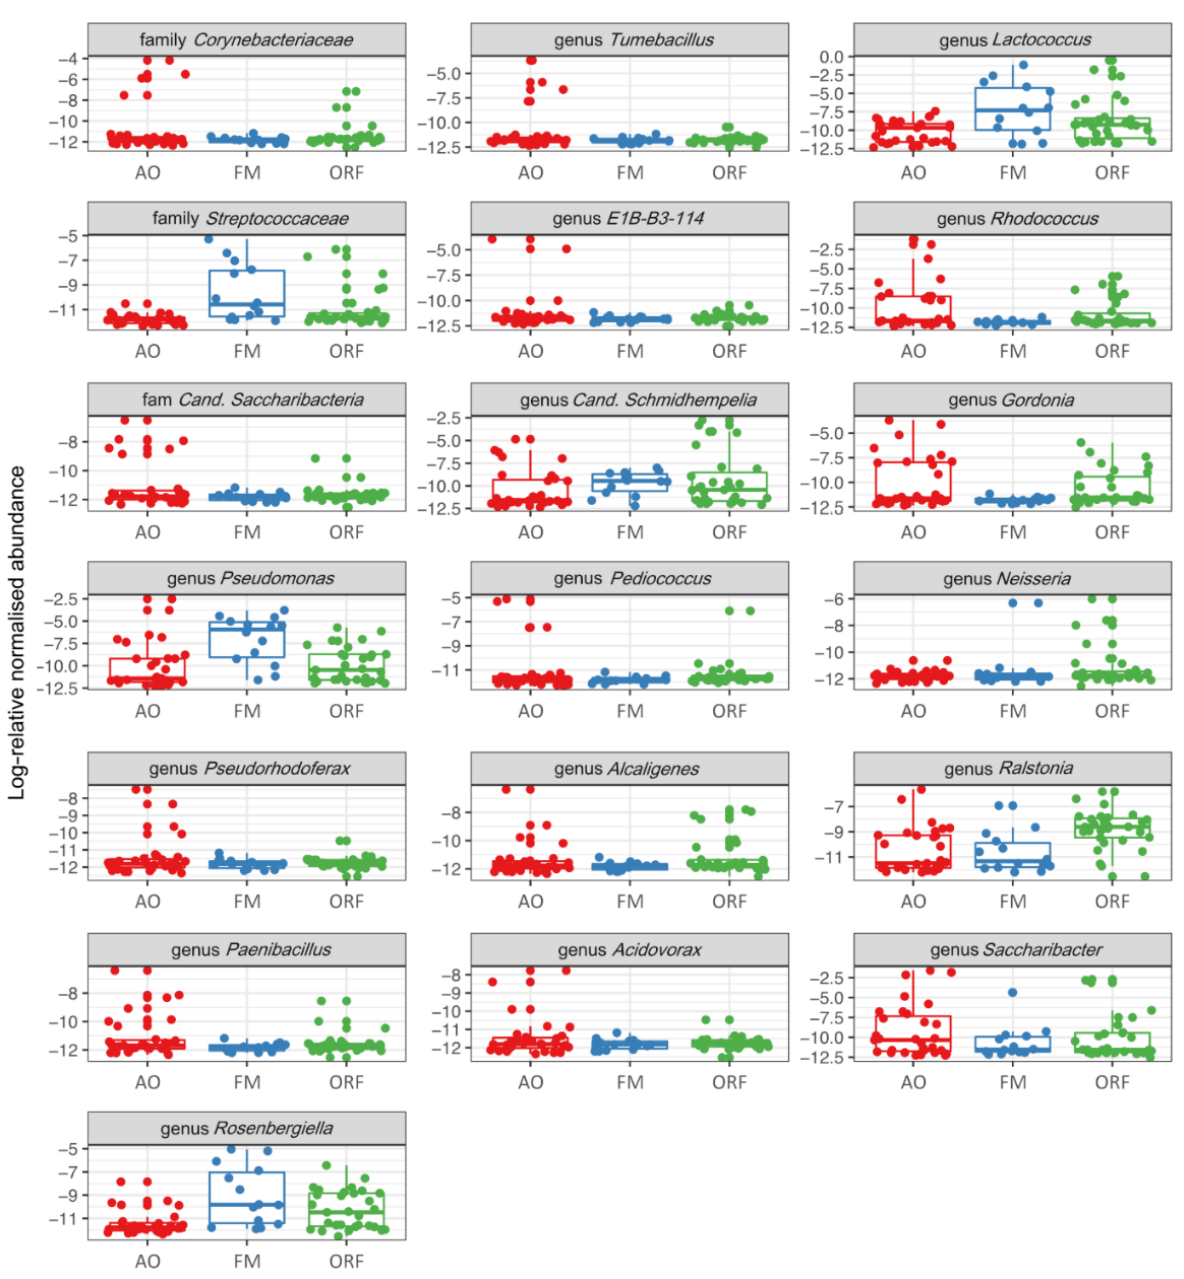
Figure 4. Log-relative abundance of the differentially expressed bacterial genera in the guts of Bombus terrestris collected from apple orchards (AO), forest meadows (FM), and oilseed rape fields (ORF).